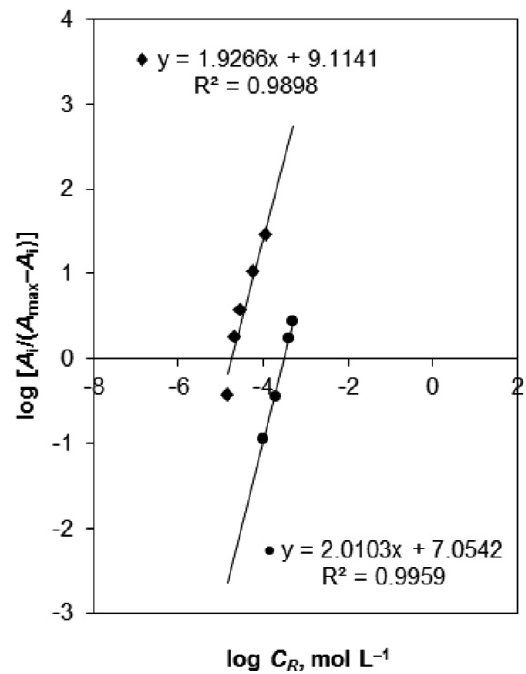
Figure 3. Straight lines by the mobile equilibrium method for deter- mination of the molar ratios Mo(VI):3,5-DTC and Mo(VI):TTC